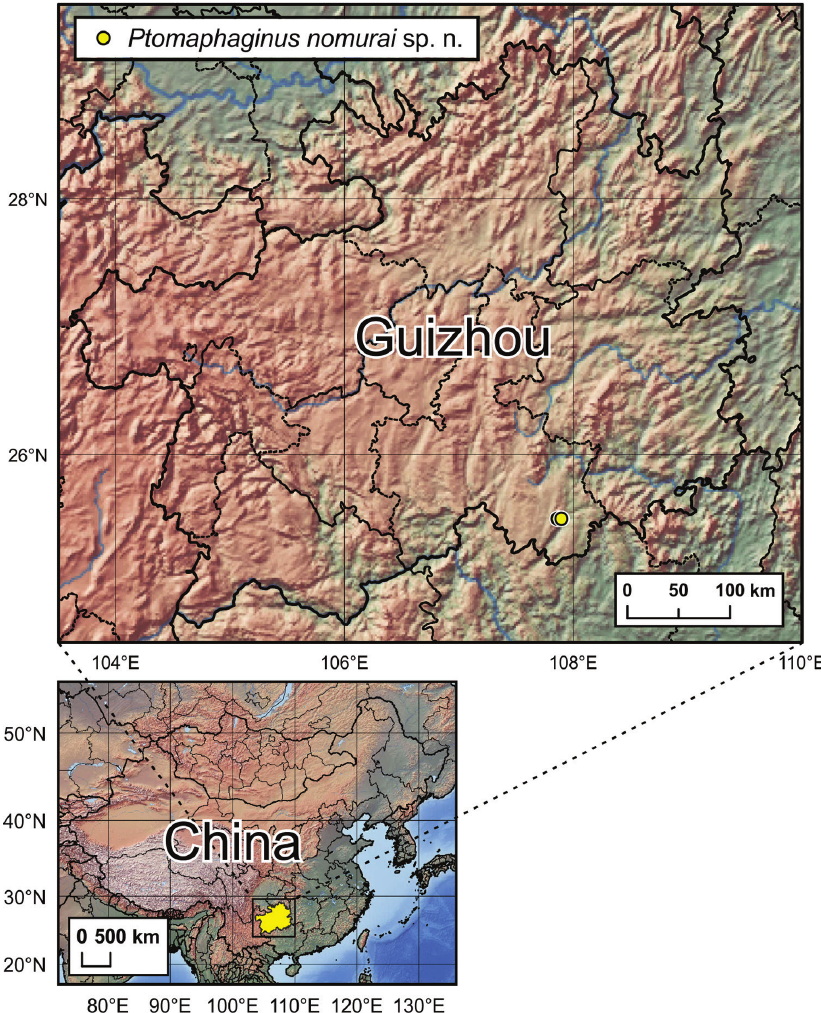
Figure 20. Distribution map of Ptomaphaginus troglodytes sp. n. in Guizhou Province,